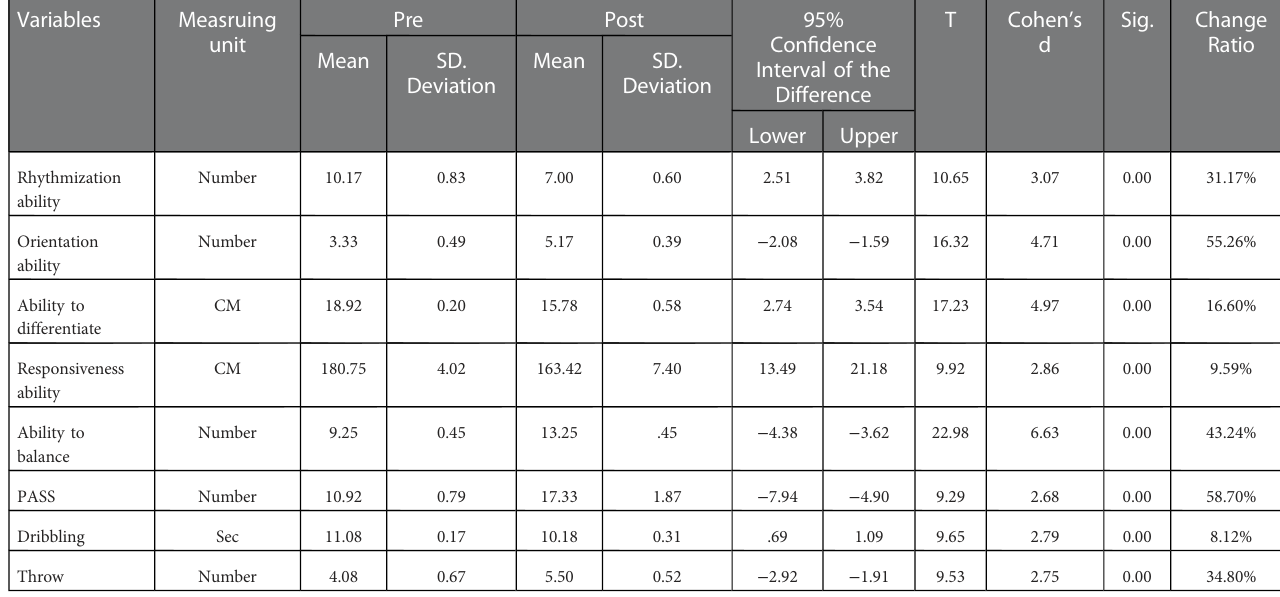
TABLE 4 Indicates the differences between the averages of pre- and post- measurements of the Controlled group in the variables under consideration ( n =12).